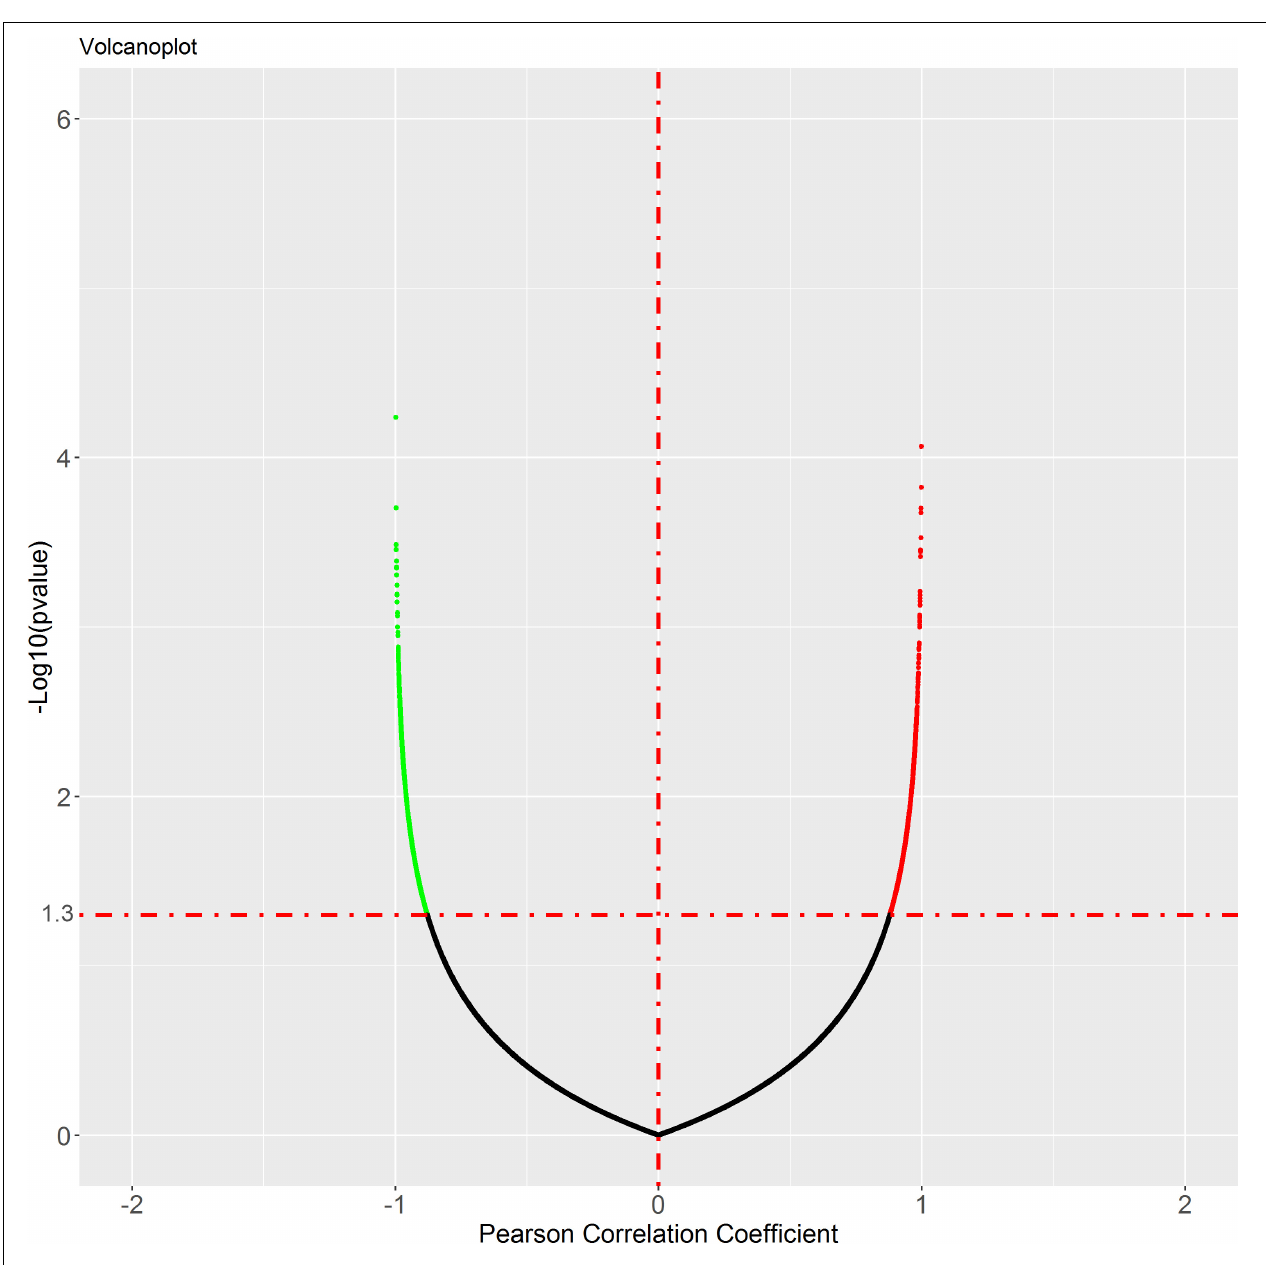
FIGURE 6 | Genes correlated with ACE2 expression in lung. In the figure, black is the gene with p value ≥ 0.05, while green is the gene with negative correlation and red is the gene with positive correlation.